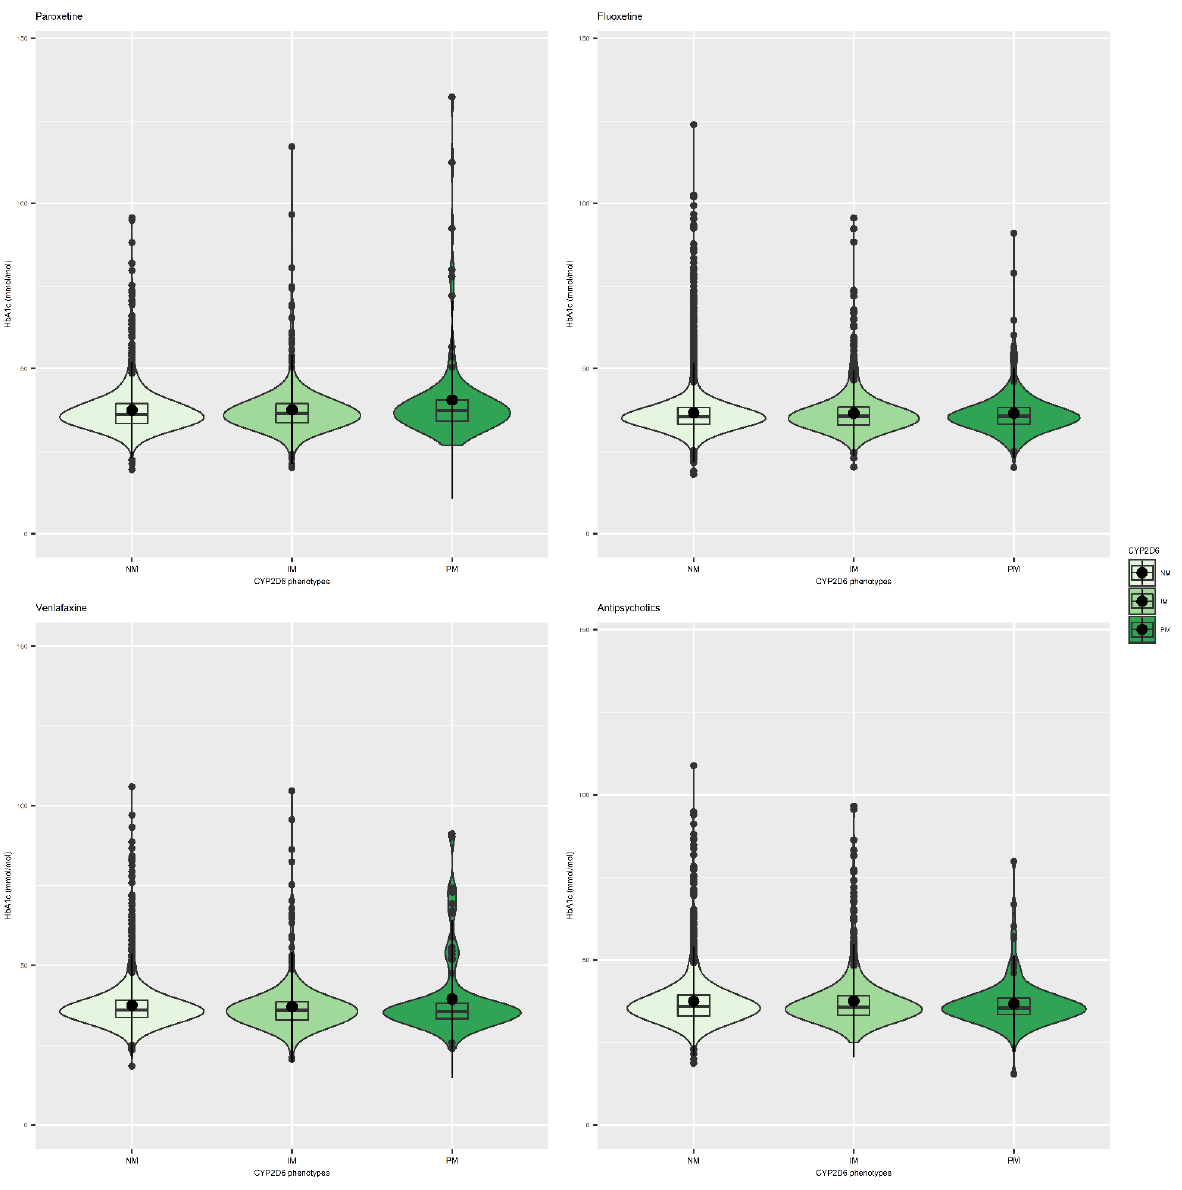
Figure 2. Violin plots showing the relationship between CYP2D6 metabolic status and HbA1c levels (mmol/mol) among subjects taking (from left to right) paroxetine, fluoxetine, venlafaxine, and all antipsychotics. Table 3. Association between CYP2D6 metabolic phenotype and HbA1c levels among